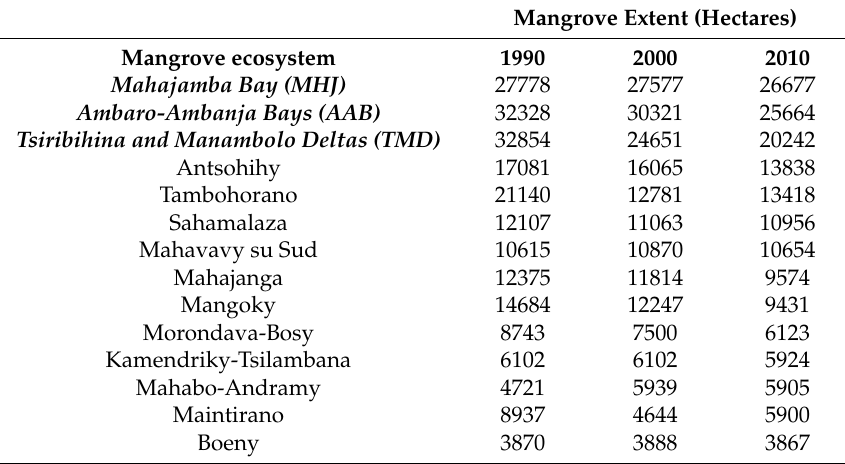
Table 3. The extent in hectares for Madagascar’s primary mangrove ecosystems for 1990, 2000 and 2010, based on partitioning USGS-produced Landsat-derived national-level mangrove cover maps for 1990, 2000 and 2010 [69] in to primary ( i.e. , >1000 ha) mangrove ecosystems. Extents are ordered from largest to smallest based on 2010